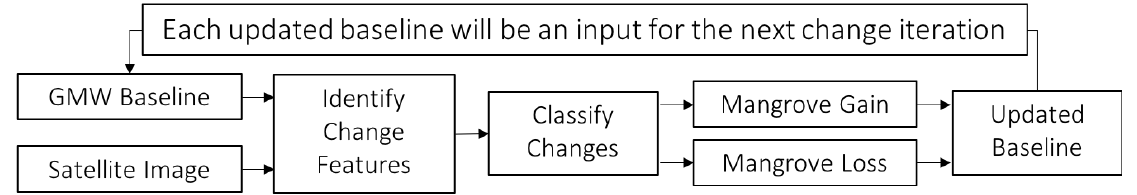
Figure 11. A flowchart of the proposed monitoring system which could be built on the 2010 GMW v2.0 baseline using the methodology of Thomas et al.